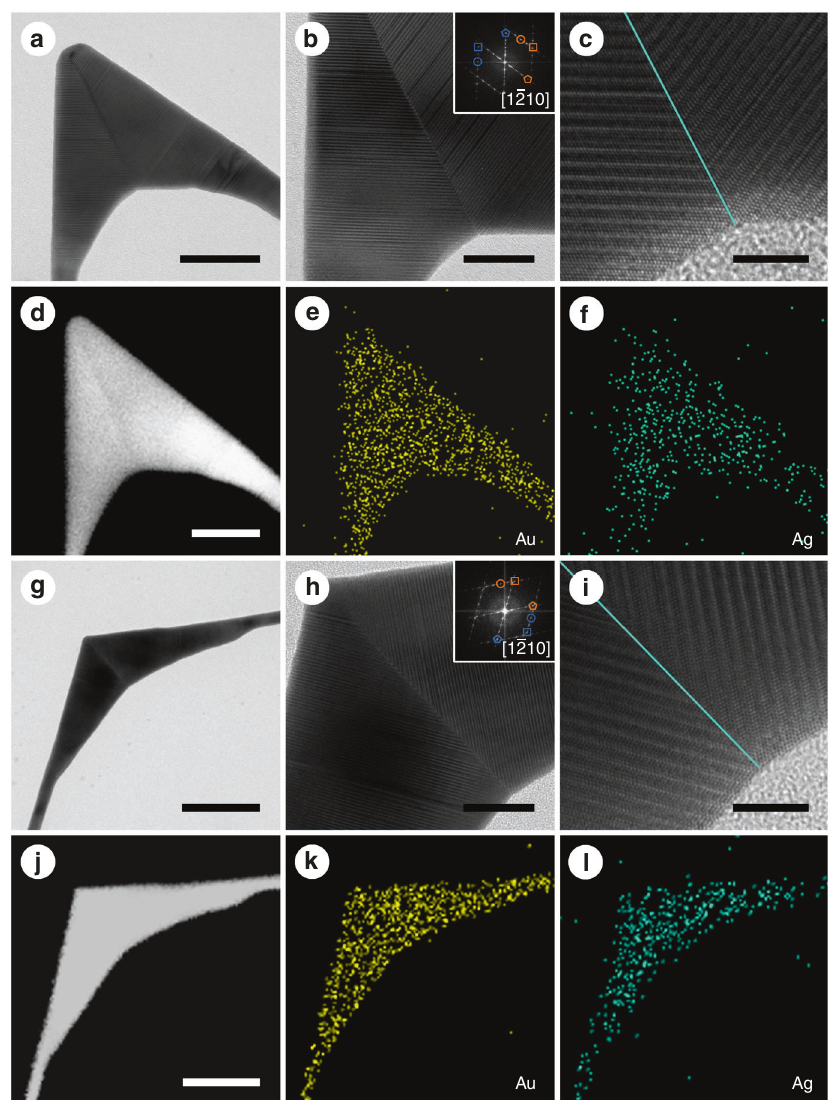
Fig. 4 Characterizations of Au@Ag twinned nanokites. a Transmission electron microscopy (TEM) image of an acute-angled Au@Ag nanokite. b High- magni fi cation TEM image and corresponding fast Fourier transform (FFT) pattern (inset) of the acute-angled Au@Ag nanokite. (0 0 0 4), (1 0 (cid:1) 1 0), and (1 0 (cid:1) 1 2) spots of 4H phase are marked with pentagons, circles, and squares, respectively. The orange and blue represent different 4H sub-crystals. c